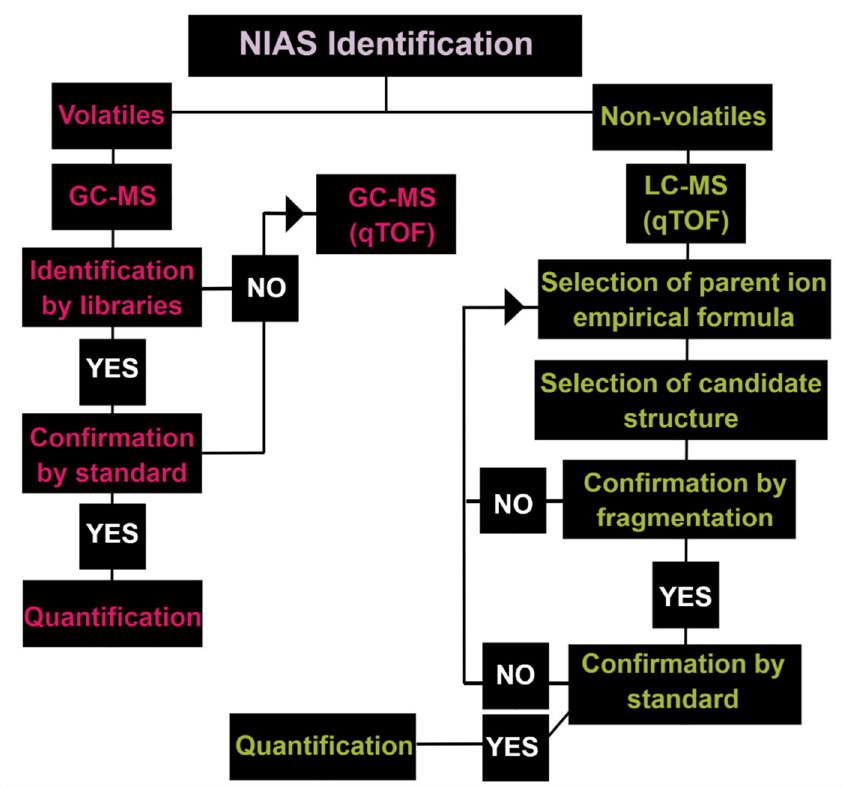
Figure 6. Example of decision tree for NIAS identification/quantification (adapted from Nerin et al.